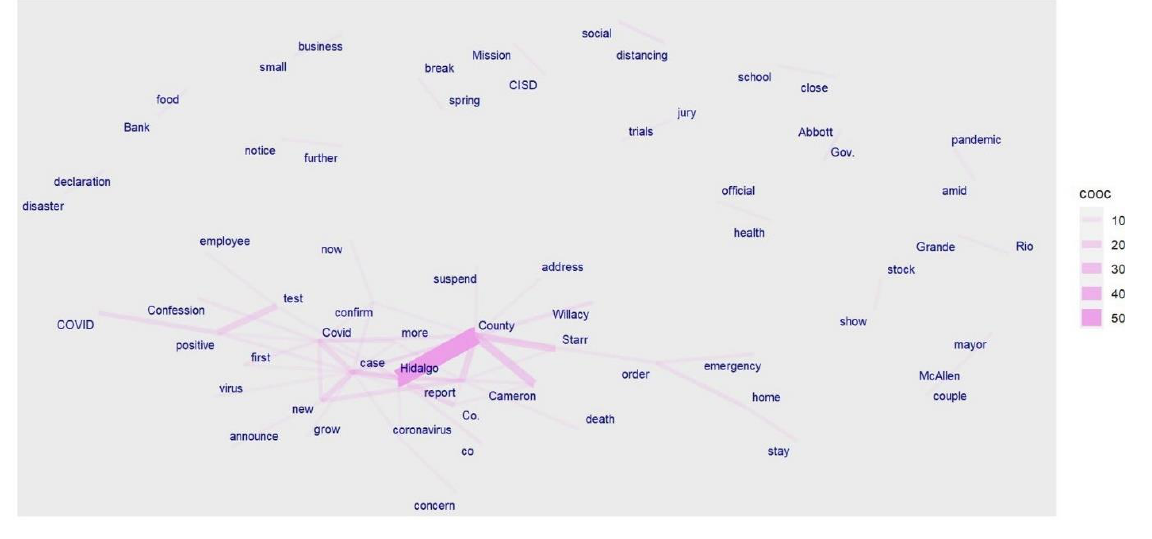
Figure 7. Words following one another (The Monitor).